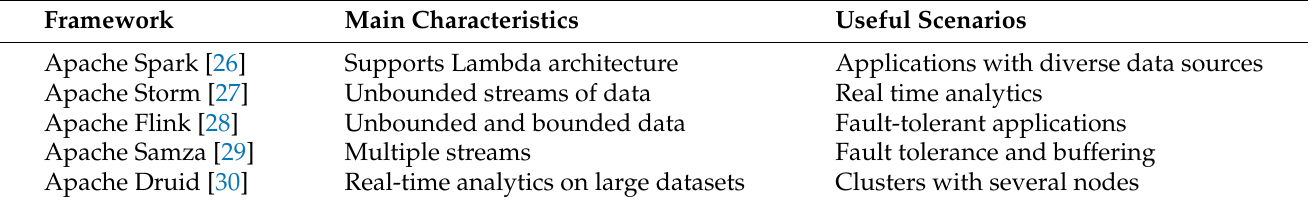
Table 4. Stream Processing frameworks